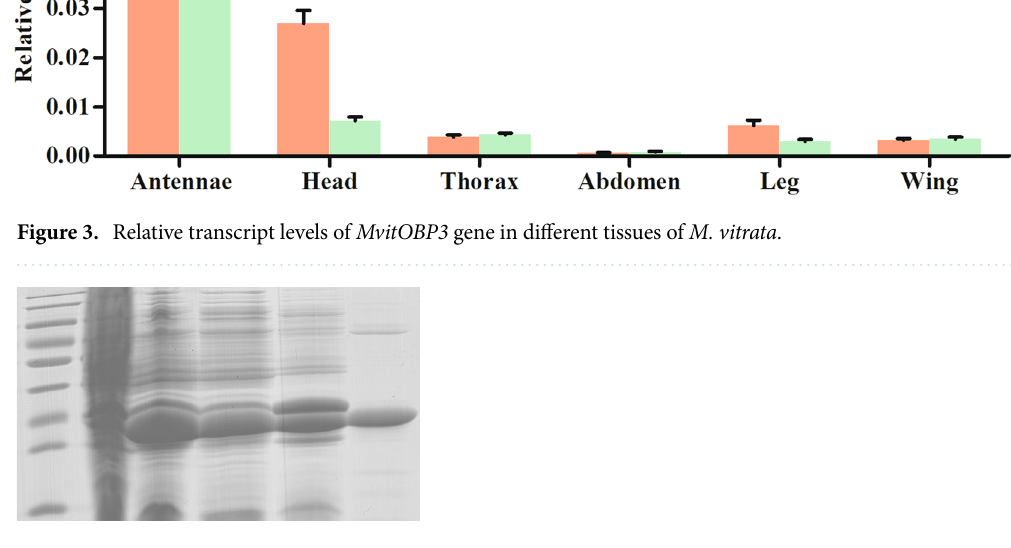
Figure 4. SDS-PAGE electrophoresis analysis of recombinant MvitOBP3. The lane is from left to right: marker protein, noninduced E. coli , induced E. coli , supernatant after broken, precipitation after broken, purified